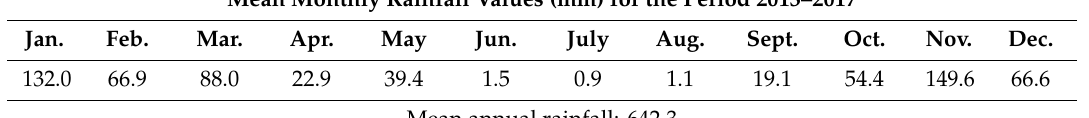
Table 2. Mean monthly rainfall values (mm) for the period 2013–2017 [31] and mean annual rainfall value (mm) for the same